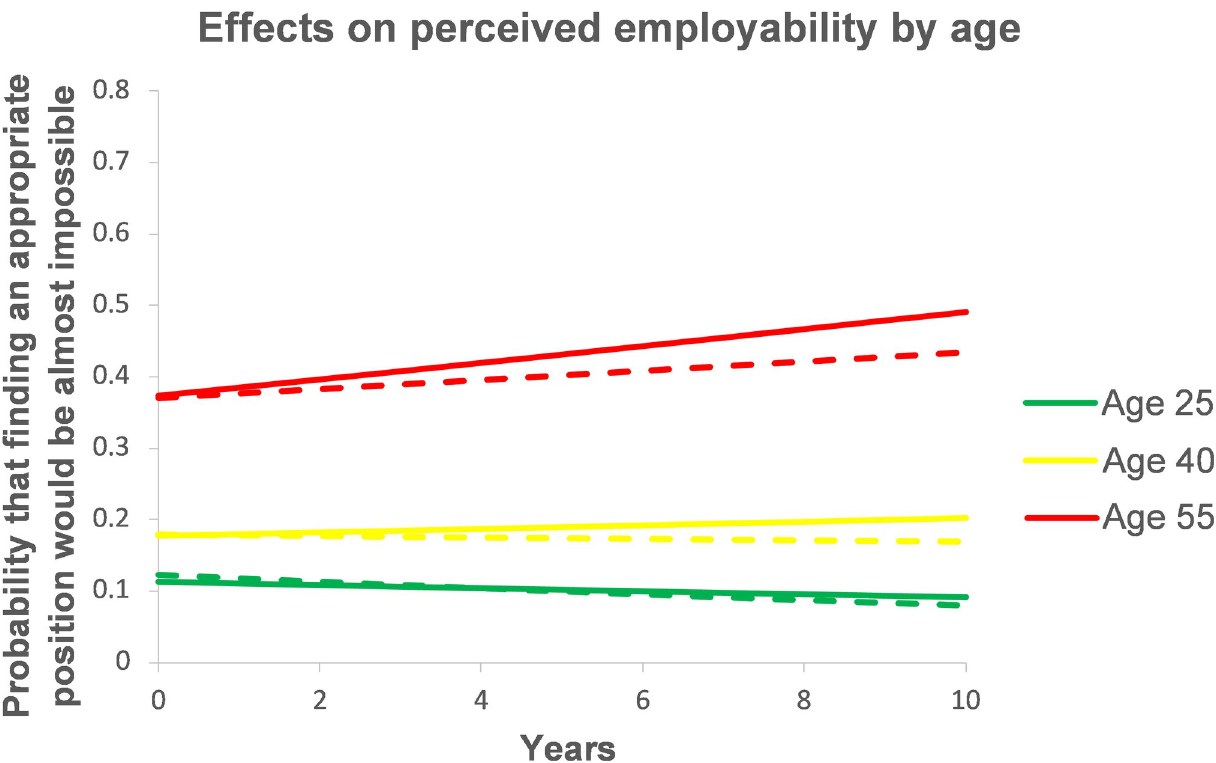
Fig 3. Moderation of the within-level effects of employment status duration by person-specific mean age across observations. Dashed lines = effects of employment duration. Solid lines = effects of organizational